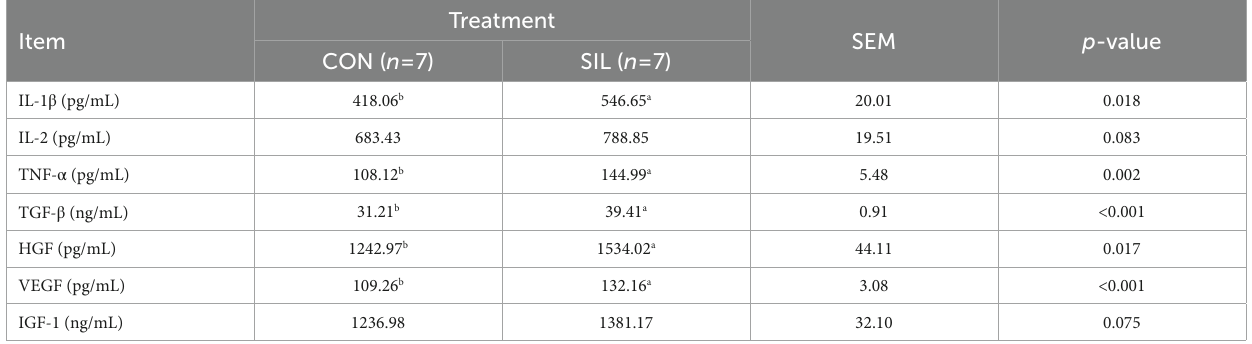
TABLE 4 Effect of silybum marianum meal as a replacement for soybean meal on serum cytokine levels in lambs.